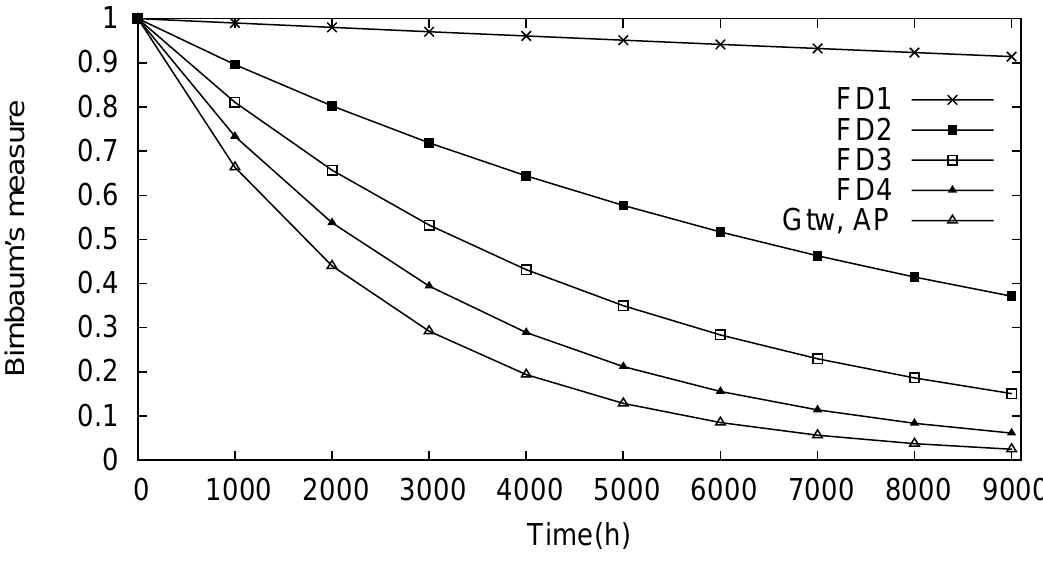
Figure 18. Analysis of the component importance based on Birnbaum measure for the line